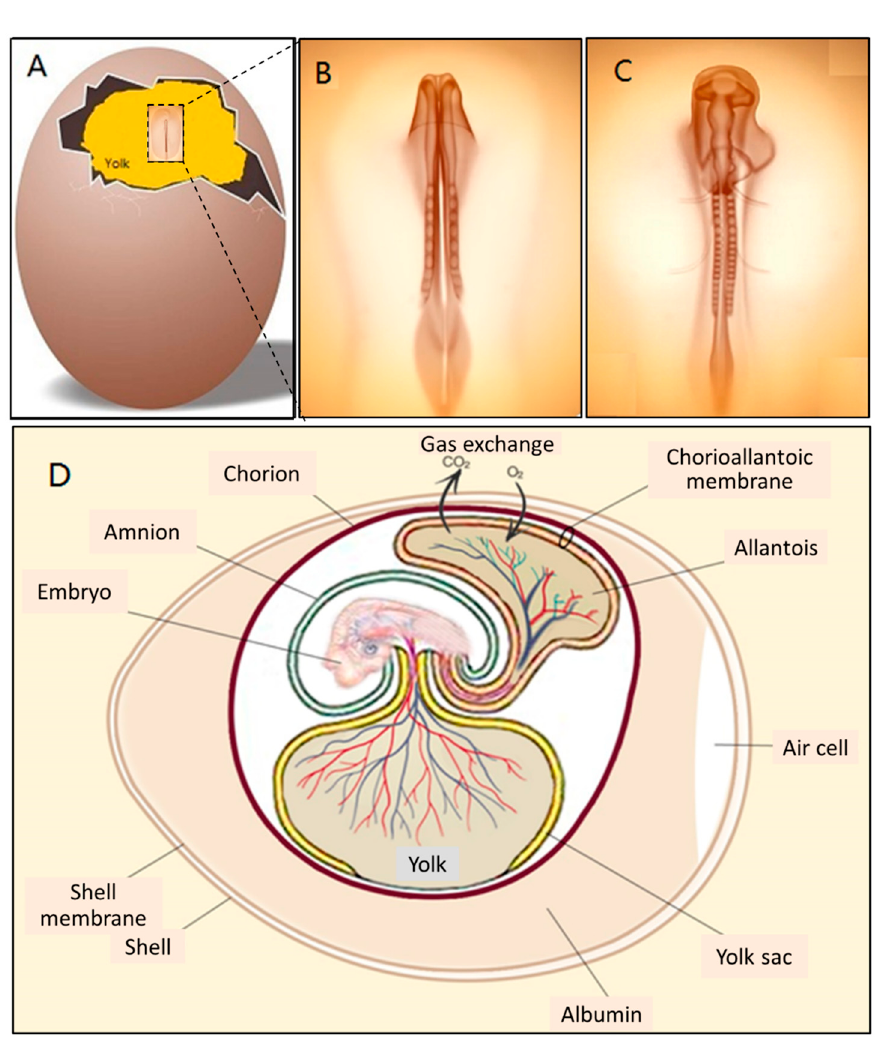
Figure 2. ( A ) A blastoderm floating on the surface of yolk on ED 2, ( B , C ) magnified views of the blastoderm in development on ED 2 and ( D ) illustration of membranes and blood circulation system of an embryonic chick egg in the middle stage.